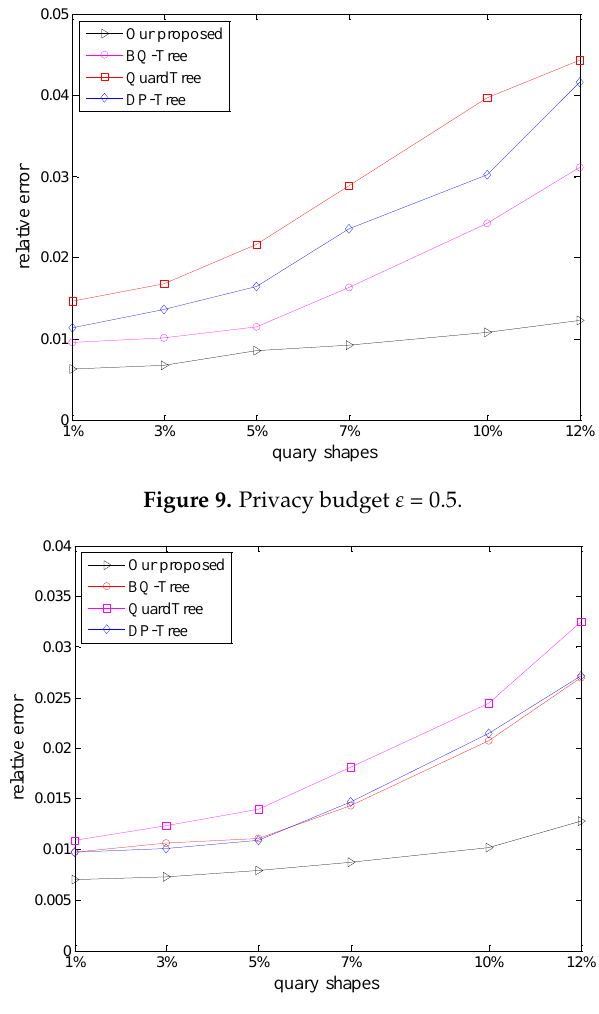
Figure 10. Privacy budget ε =